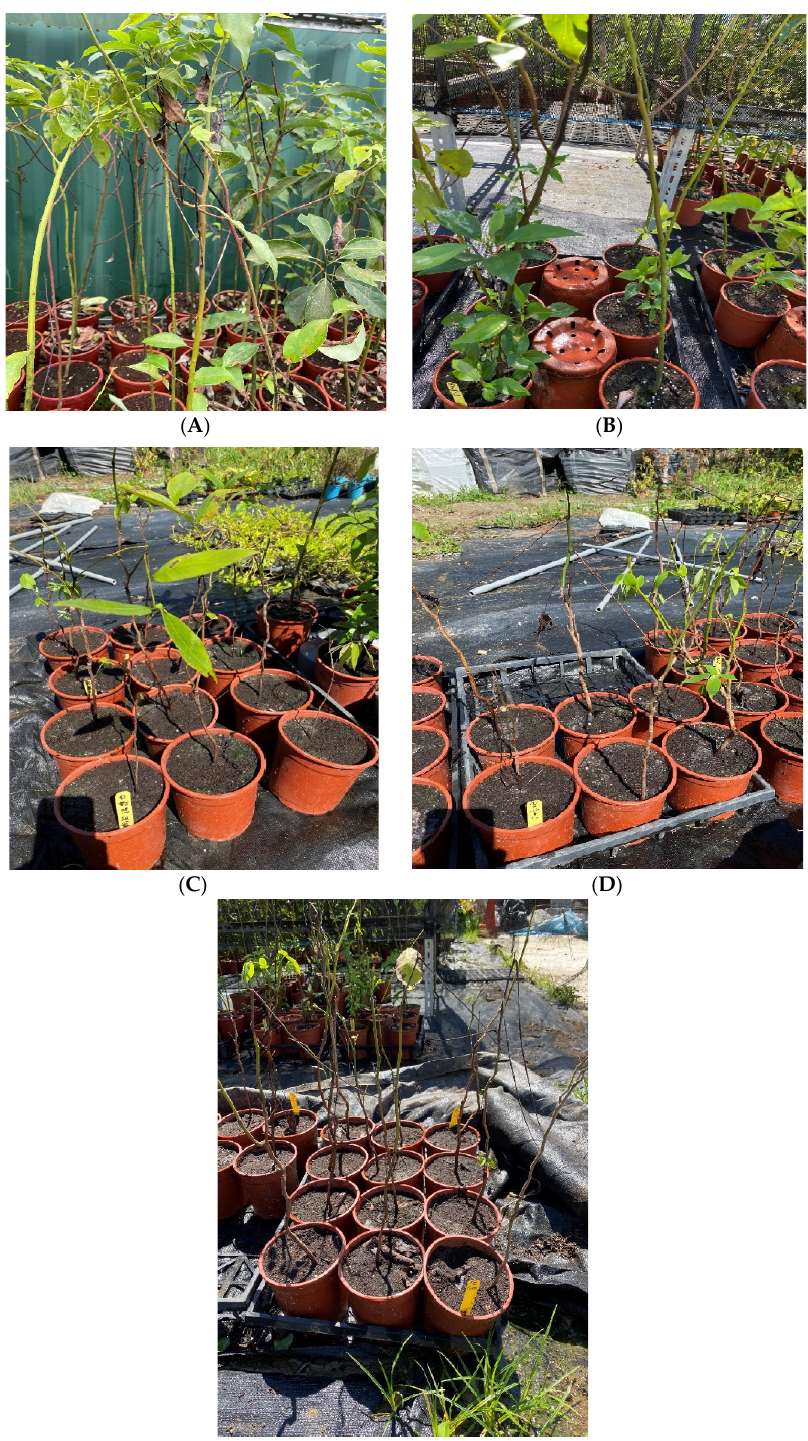
( B ) Figure 1. Saplings of camphor and golden shower trees in the 5” pot before the spray. ( A ) Camphor. ( B ) Golden shower. The experimental design included one water ‐ sprayed control and eight ethephon ‐ related treatments for each of the two species by using a completely randomized design. Each treatment had two sprays in 4 days. The water ‐ sprayed control used water for both sprays. The eight ethephon ‐ related treatments were all sprayed with 1000 mg ∙ L − 1 of ethephon solution in the first spray on 11 May. The second spray was conducted three days later with four different doses of ethephon solution: 500 mg ∙ L − 1 , 1000 mg ∙ L − 1 , 2000 mg ∙ L − 1 , and 3000 mg ∙ L − 1 ; and another four treatments involving the above four doses, each adding 8000 mg ∙ L − 1 of CA (Table 1). Both sprays used a 1.5 L hand sprayer to apply the solution to both sides of the leaves until the liquid flowed down and avoided spraying the apical buds. No surfactant was used. Each treatment had six replicates. We set 50 days from the first spray as the experimental period, which was what most tree transplant pro ‐ jects used to evaluate the transplant survival. We counted the number of leaves on each of the testing saplings on 11 May as the original leaf number and counted the leaf number on the saplings weekly to monitor the effect of ethephon/CA. The foliage retention rates of the saplings were calculated by the number of leaves remaining on the saplings divided by the original leave number. We categorized the foliage retention rates into five groups: 0%, 20%, 40%, 60%, 80%, and 100% by rounding the calculated percentages to the highest percentage of the group (Figure 2). For example, retention rates between 0–20% were recorded as 20%; retention rates be ‐ tween 20.1–40% were recorded as 40%, …, etc.